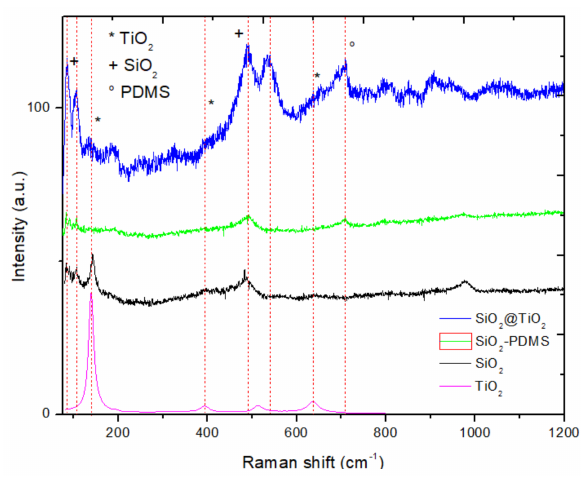
Figure 7. Raman spectra in the range of 80–1200 cm − 1 from TiO 2 , SiO 2 and SiO 2 @TiO 2